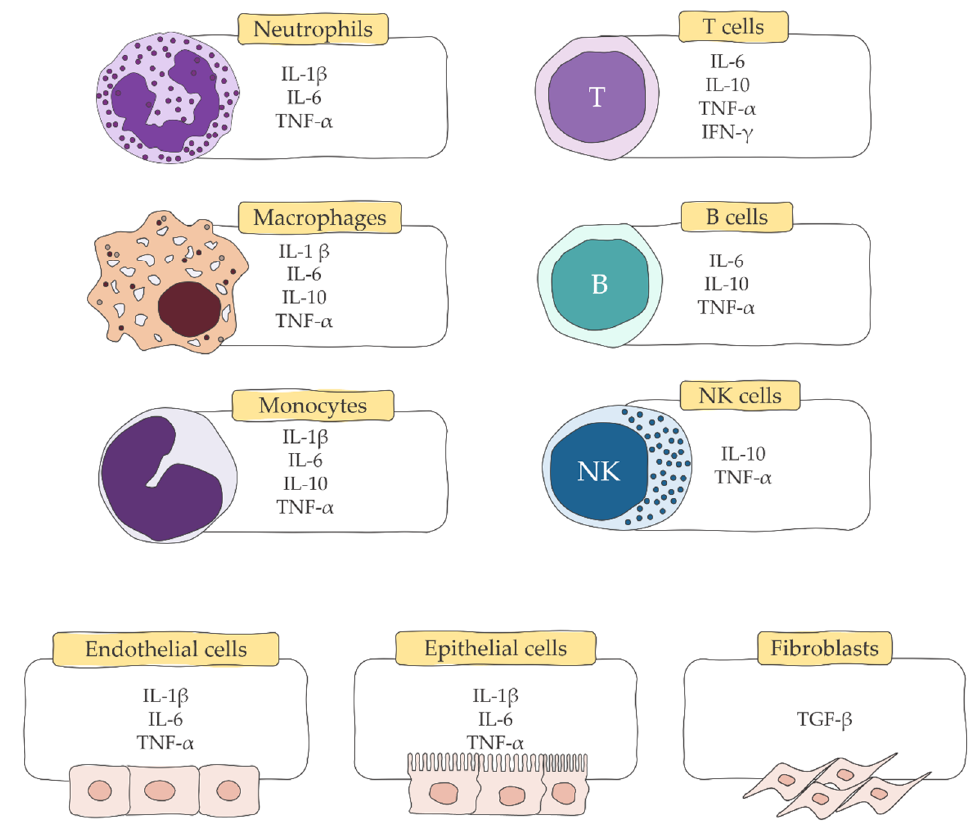
Figure 3. Schematic representation of cells involved in the immune response expressing different cytokines. Abbreviations: IL, interleukin; TNF, tumor necrosis factor; IFN, interferon; TGF, trans- forming growth factor; NK, natural killer (based on [93,94]).